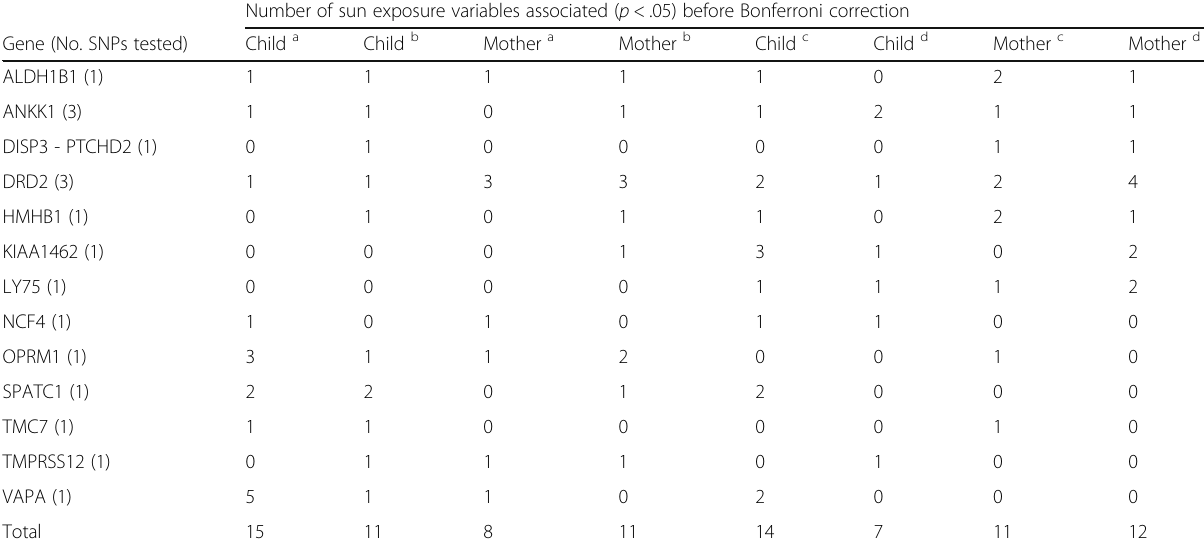
Table 2 Number of associated sun exposure variables for children and mothers by gene before Bonferroni correction Number of sun exposure variables associated ( p < .05) before Bonferroni correction Gene (No. SNPs